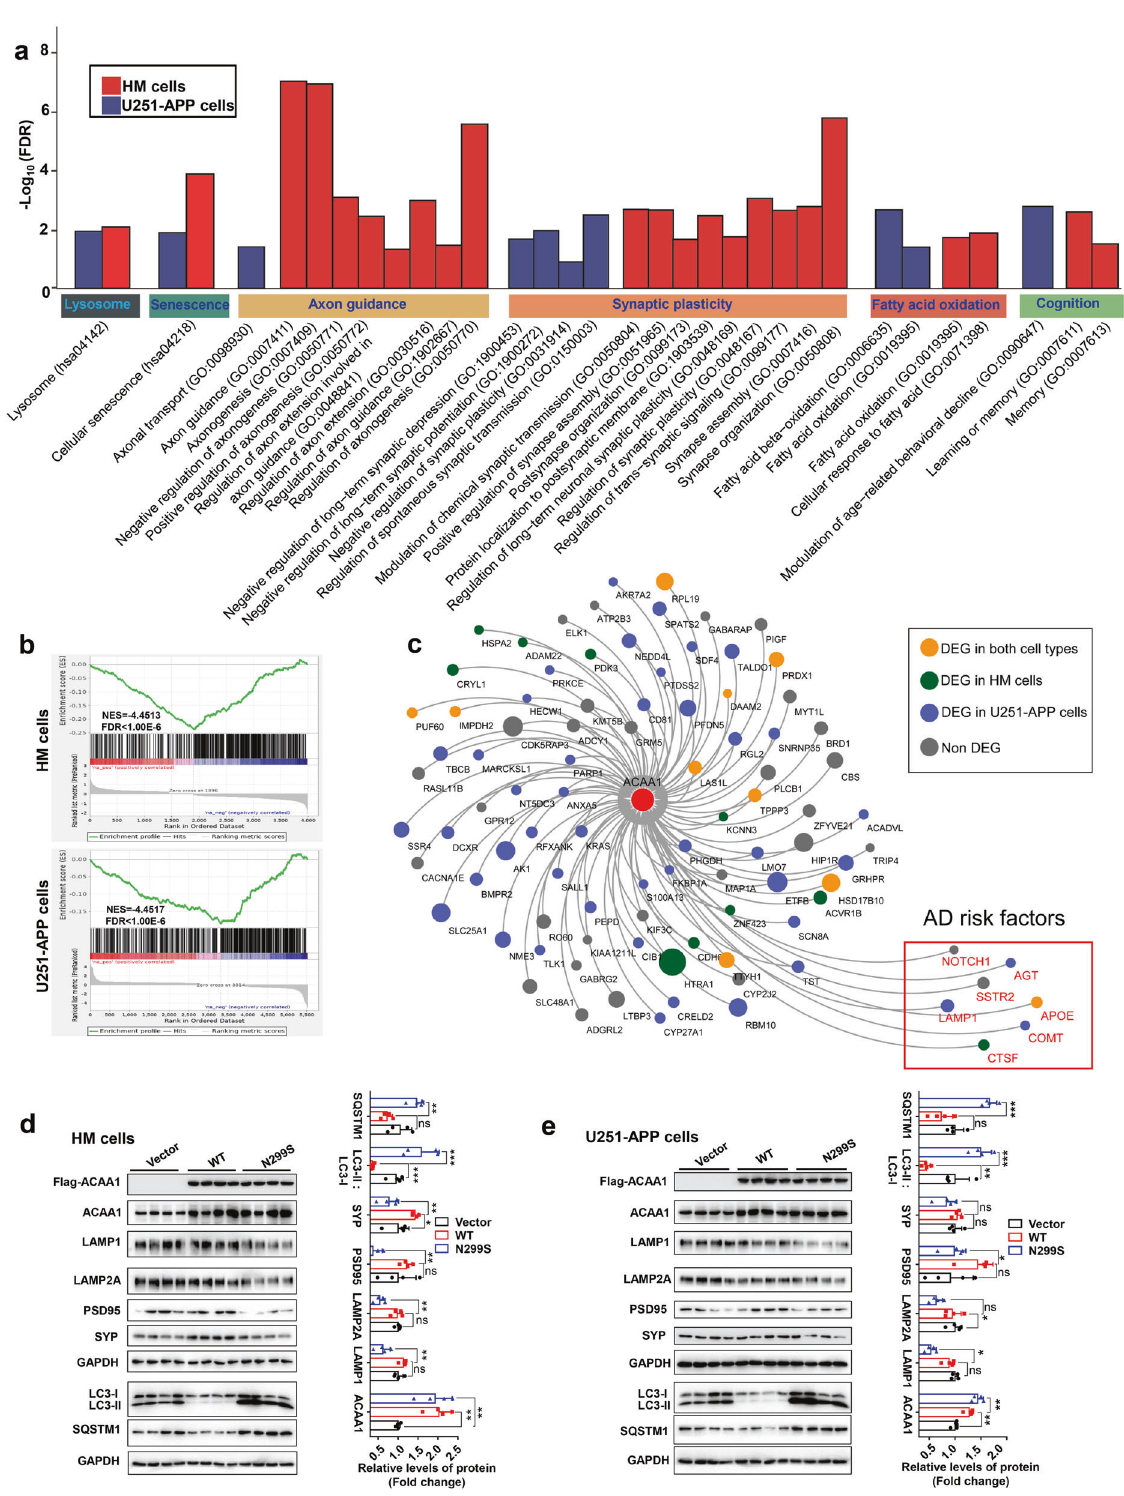
Fig. 2 Overexpression of ACAA1 p.N299S disturbed global gene expression pattern and inhibited lysosomal and synaptic proteins in human cells. a KEGG pathway and GO biological processes analyses of differentially expressed genes in the HM and U251-APP cells overexpressing ACAA1 p.N299S and ACAA1 WT. b Enrichment of neuron development genes in cells with overexpression of ACAA1 p.N299S versus ACAA1 WT (upper, HM cells; below, U251-APP cells) based on gene set enrichment analyses (GSEA). c Overexpression of ACAA1 p.N299S versus ACAA1 WT affects co-expression network constructed using human AD brain tissues. d , e Overexpression of ACAA1 p.N299S in HM ( d ) and U251-APP cells ( e ) reduced the levels of lysosomal and postsynaptic proteins and increased LC3-II:LC3-I ratio and SQSTM1 protein level. The GAPDH was used as the loading control. Data are representative of three independent experiments with similar results. Bars represent mean ± SD of the three experiments. ns, not signi fi cant; * P < 0.05; ** P < 0.01; *** P < 0.001; Student ’ s t